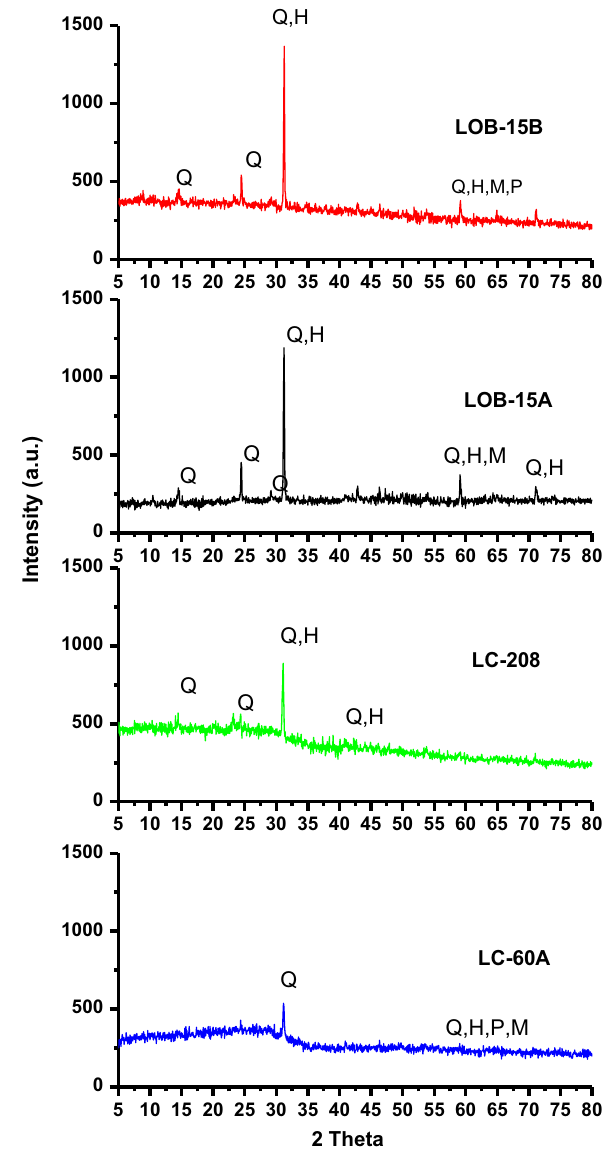
Fig. 33 XRD pattern of leached coal and OB of Ledo